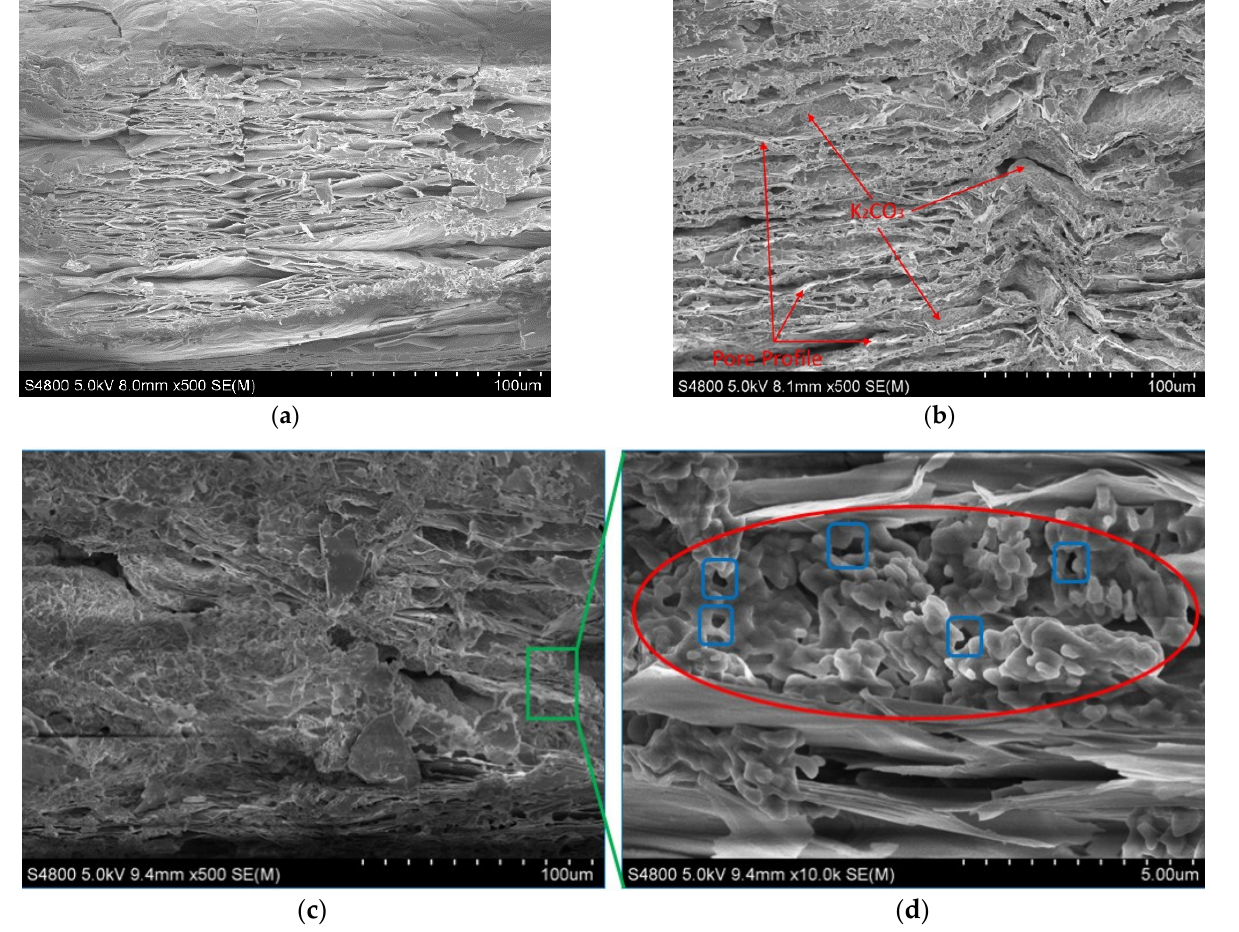
Figure 8. SEM images of EVM, KE1-2 and KE1-4 samples surfaces. ( a ) EVM; ( b ) KE1-2; ( c ) KE1-4; and ( d ) KE1-4 Porosity.